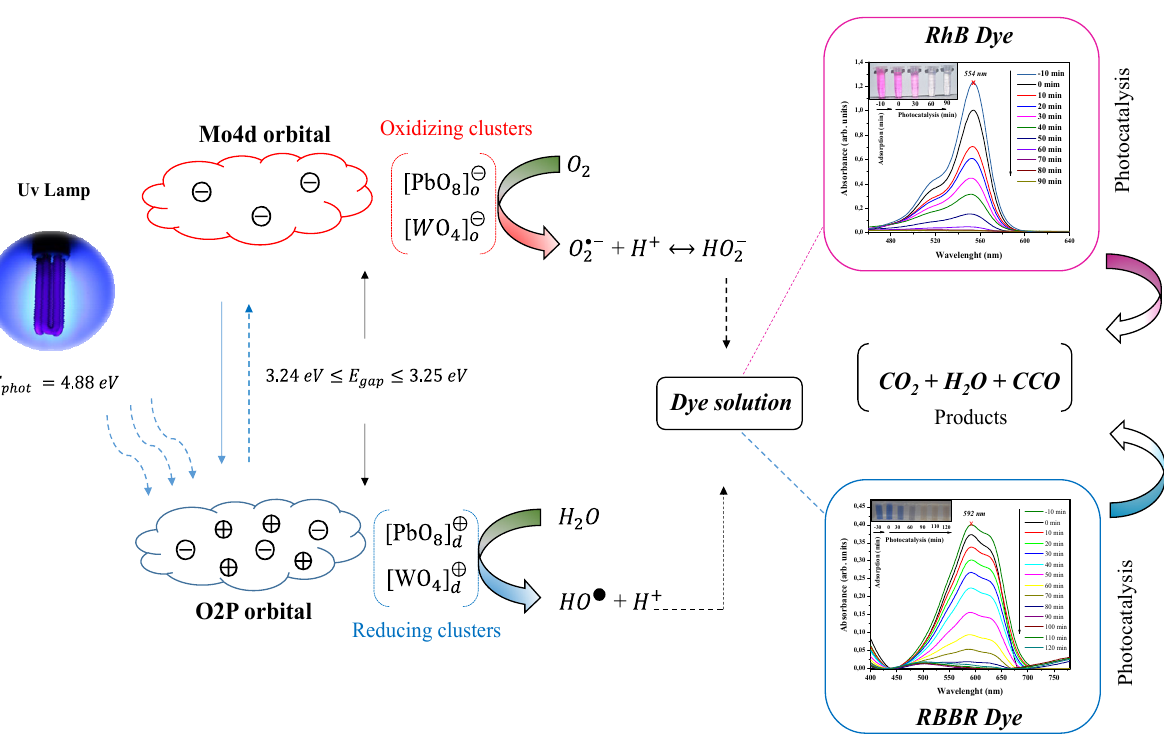
Figure 11. Scheme of the photocatalytic process after absorption of UV light, resulting in degradation of RhB (cationic) and RBBR dye (anionic) by oxidant effect. The adsorption mechanism of the molecules on the surface of the nanocrystals initially promotes equilibrium by electrostatic attraction [41,42,63,65]. When irradiated with the three UV lamps ( λ = 253 nm; E photon = 4.88 eV), the nanocrystals absorb the photon energy with bandgap ( E gap ) value (3.24 ≤ E gap ≤ 3.25), resulting in excitation/recombination of the electrons ( (cid:9) ), thus generating the holes ( h + = ⊕ ) [17]. The crystalline defects and deformations in the length and angle of the bonds in the deltahedral [PbO 8 ] and tetrahedral [MoO 4 ] clusters play a fundamental role in the efficiency of the electron/hole pairing process. In this way, we believed that the order/structural disorder exhibits different types of order clusters ([PbO 8 ] o , [MoO 4 ] o ) and disordered ([PbO 8 ] d , [MoO 4 ] d ) [56]. Other factors can be considered in this process, among which we highlight the presence of vacancies of oxygen atoms, energy surfaces ( E surf ), crystallite size and microdeformations, promoting insertion of intermediate levels between the valence band and conduction band [8,17]. Based on the obtained results, mainly in the X-ray diffraction analysis and photo- catalytic experiments, we proposed that: (i) the smallest crystallite size; (ii) high adsorp- tion capacity and (iii) density of defects in the structure for sample PbMoO 4 -10 promote polarization at the short and long range of the ordered clusters ( [ PbO 6 ] x / [ MoO 4 ] x and o o tures of the nanocrystals [9]. Consequently, the efficient excitation/recombination